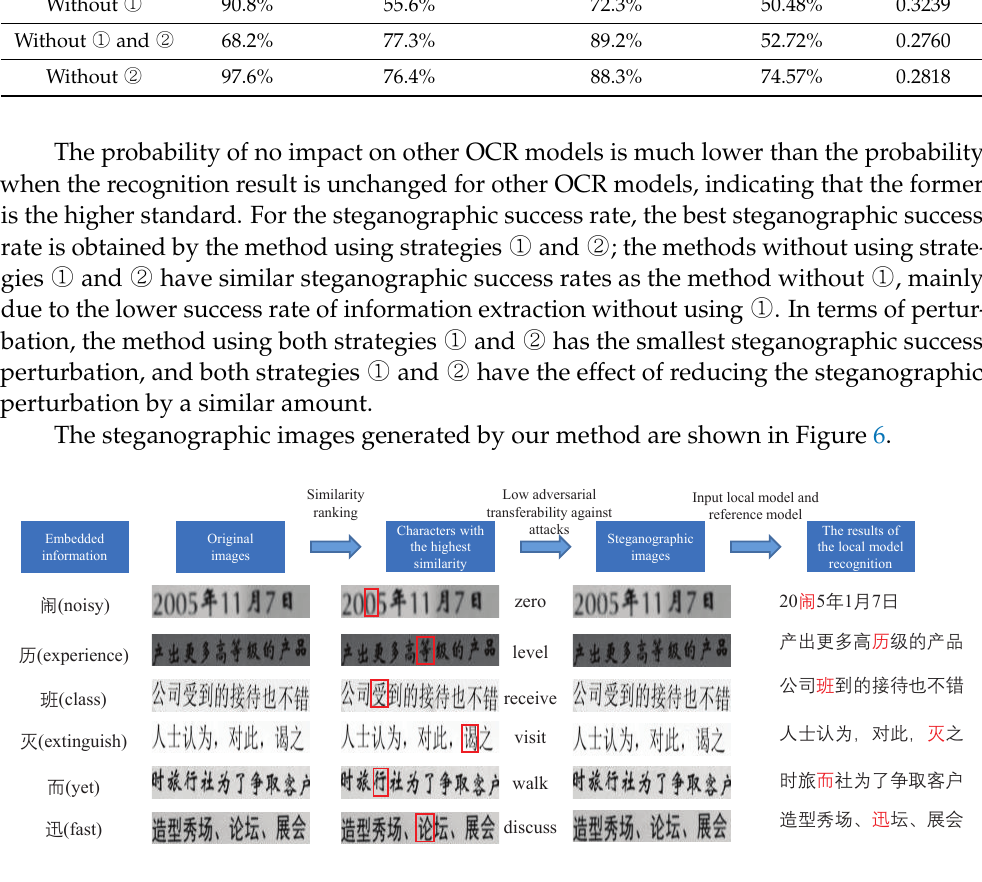
Figure 6. The steganographic image generated by our method. The semantics of the selected character in the original sample is completely